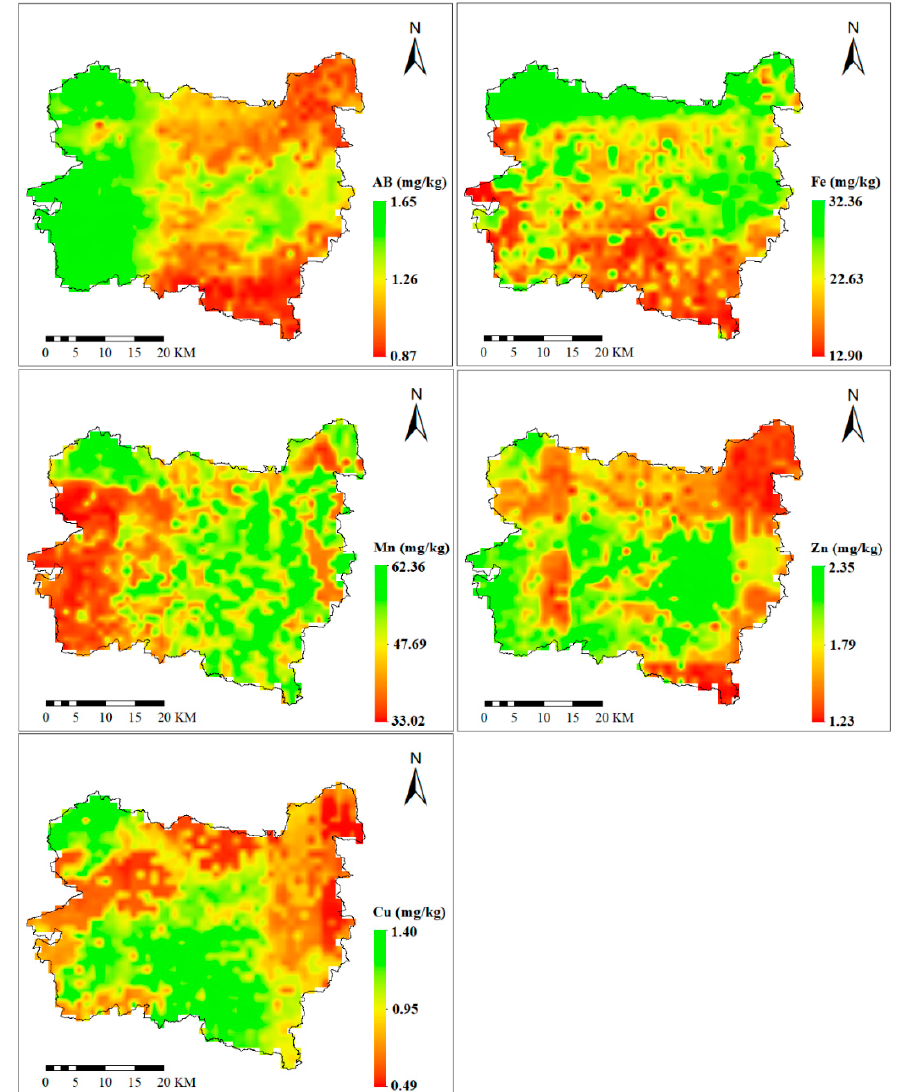
Figure 6. Spatial distribution maps of micronutrients in soils. (AB indicates soil available boron; Fe, Mn, Zn, and Cu indicate soil iron, manganese, zinc, and copper).